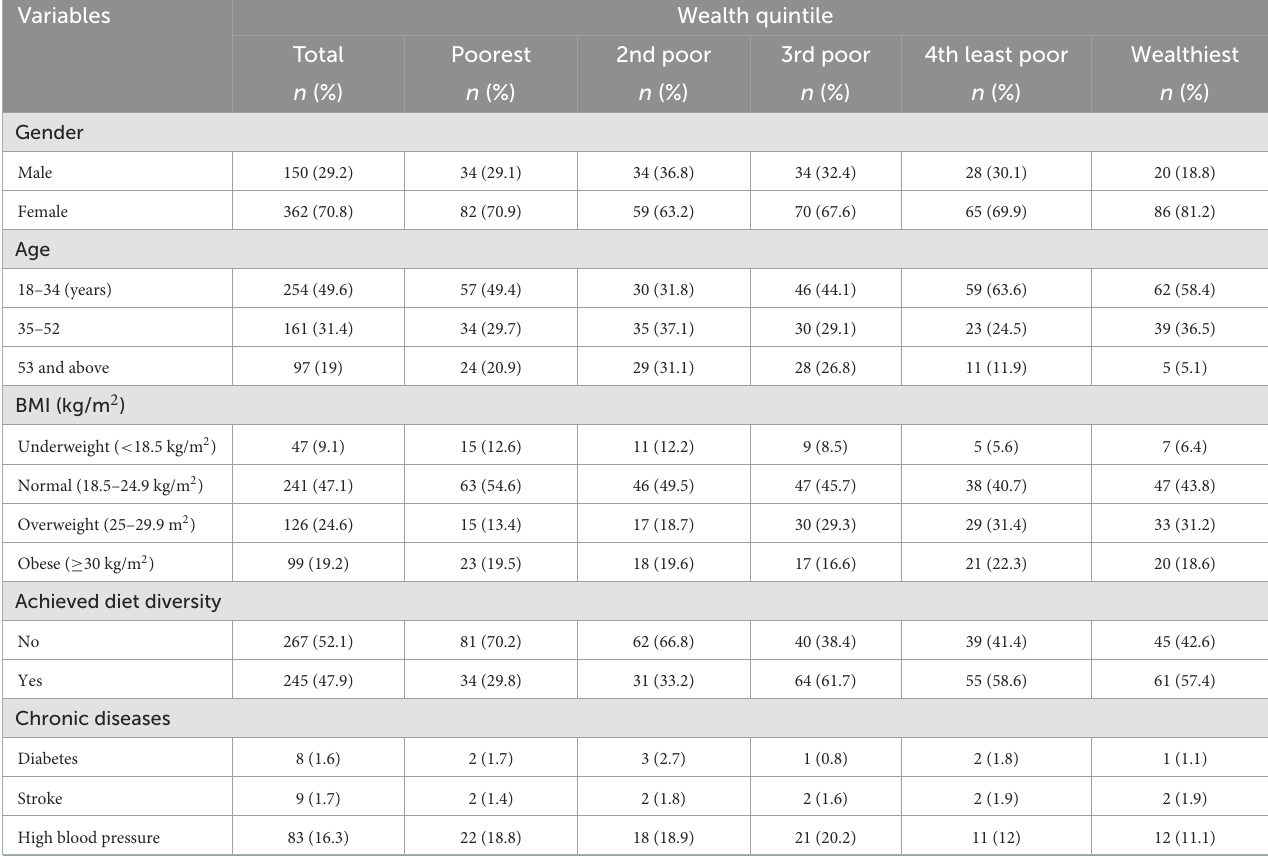
TABLE 3 Descriptive statistics of individual participants by household wealth quintiles in hypermarket study, Western Region, Kenya ( n = 512).